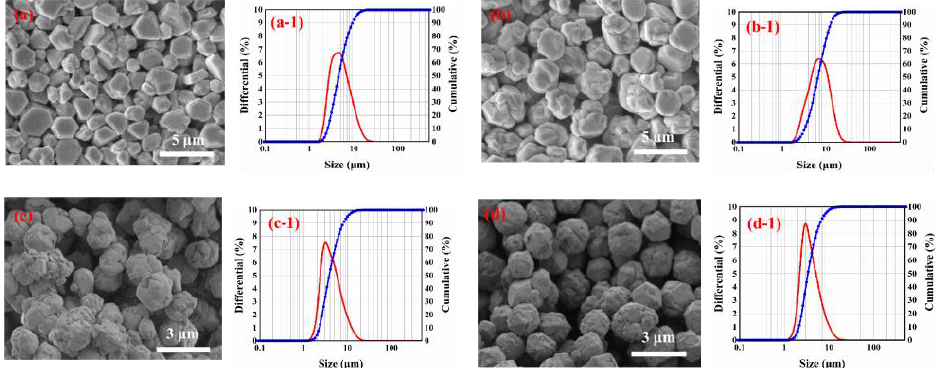
Figure 5. SEM images of silver particles prepared with different dispersants: ( a ) gelatin; ( b ) stearic acid; ( c ) succinic acid; ( d ) glutaric acid. Size distribution of silver particles prepared with different dispersants: (a-1) gelatin; (b-1) stearic acid; (c-1) succinic acid.